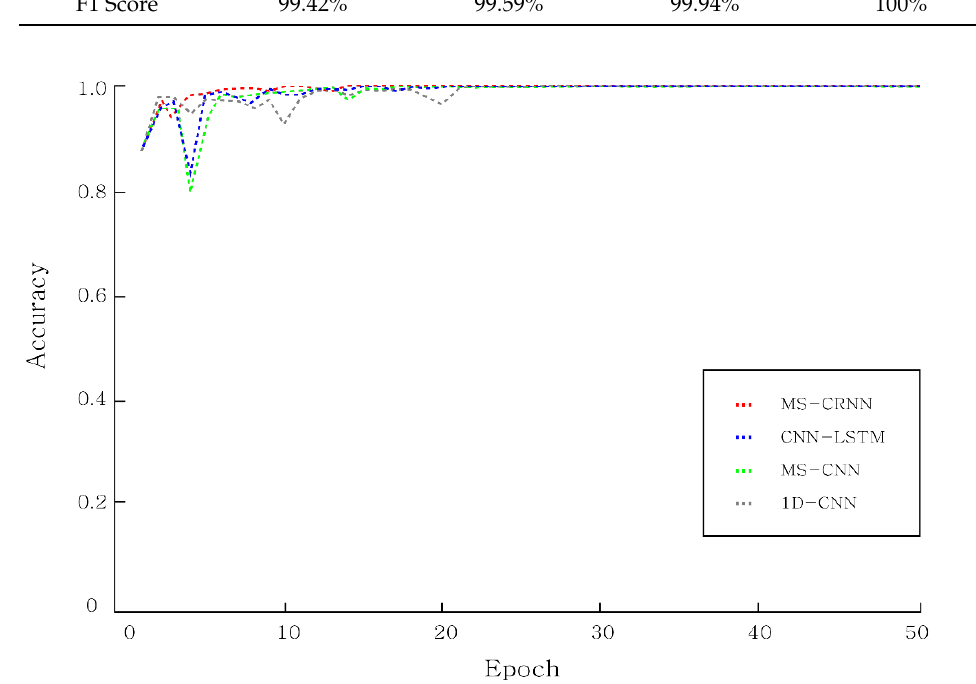
Figure 8. Plot of the experimental results obtained for the original CWRU data state.